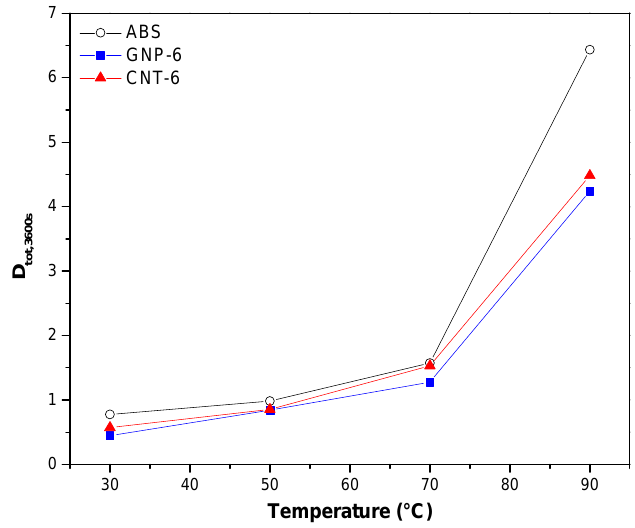
Figure 7. Creep compliance ( D tot ,3600s ) of neat ABS, GNP-6 and CNT-6 nanocomposites at 3.9 MPa at various temperatures in the range of measurements.